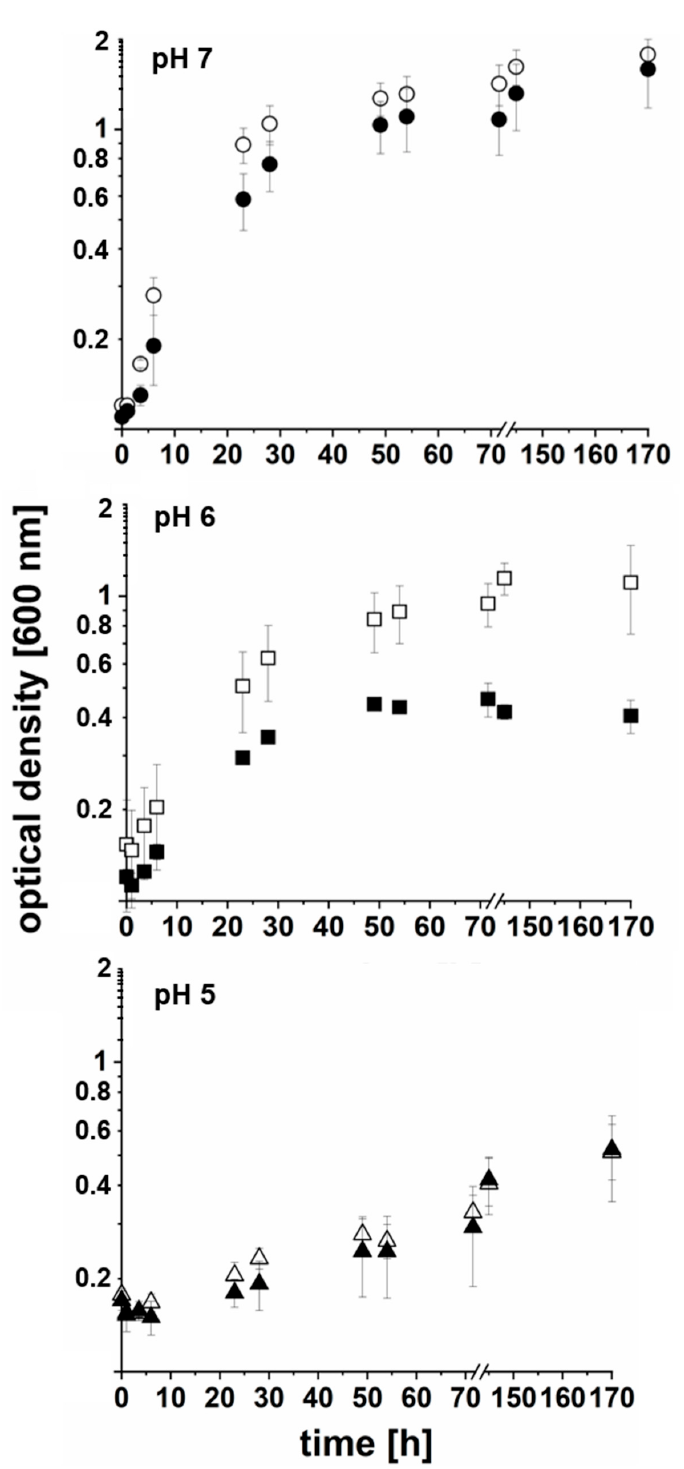
Figure 3. Effect of L-asparagine on the growth of P. bivia at varying pH. P. bivia was cultivated in medium with (black symbols) or without (white symbols) supplementation of 50 mM of L-asparagine. The initial pH of the medium was 7.0 (circles; top panel), 6.0 (squares; middle panel), and 5.0 (triangles; lower panel). Average and standard deviations of three biological replicates are shown.